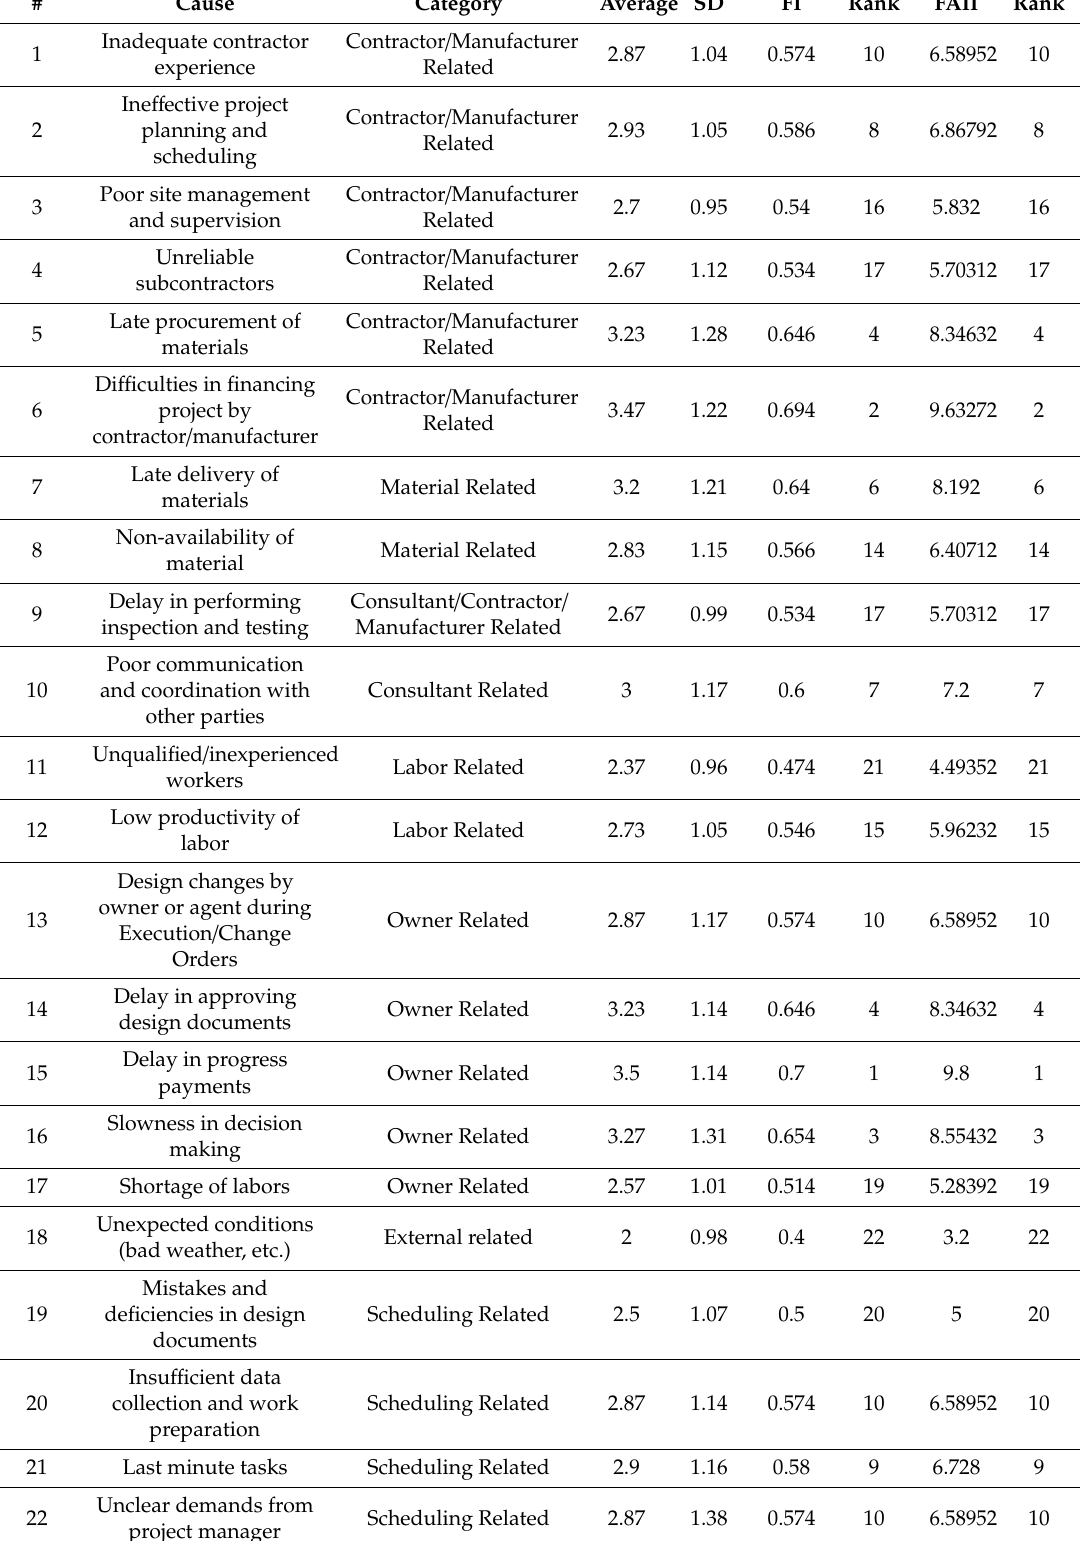
Table 3. The identified causes of delay, their average, SD, and